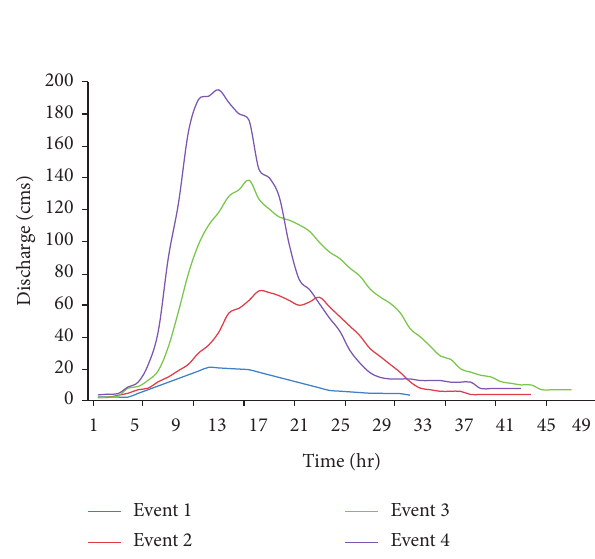
Figure 2: Observed hydrographs used to validate the model generated